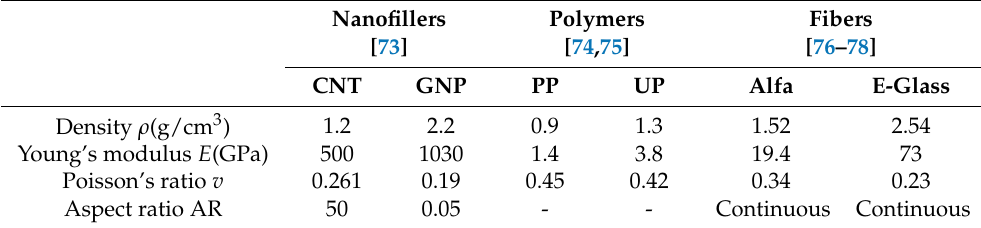
Table 1. Mechanical properties of nanofillers, polymers and